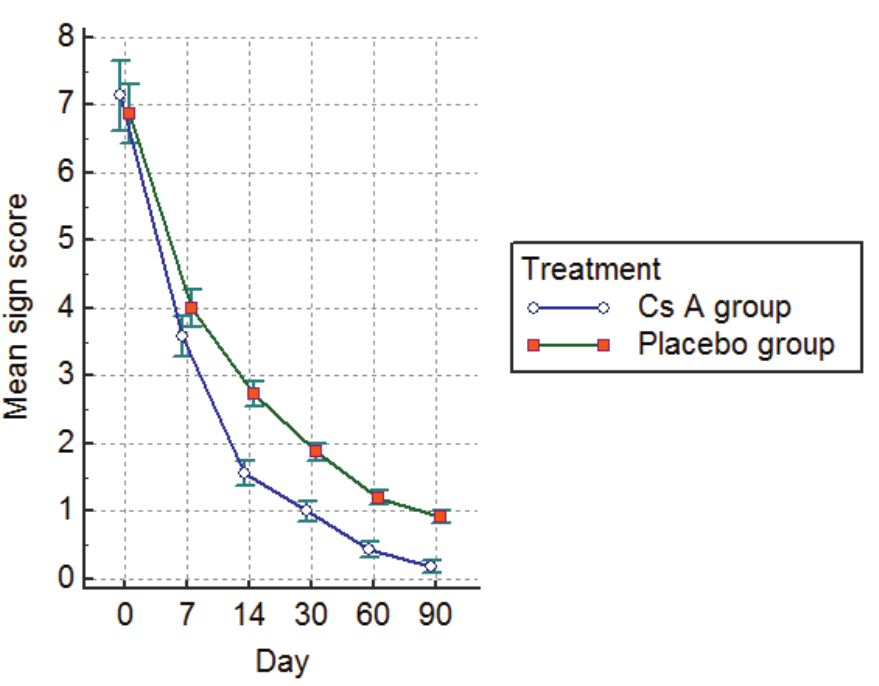
Figure 2. Mean sign scores at baseline and during follow-up